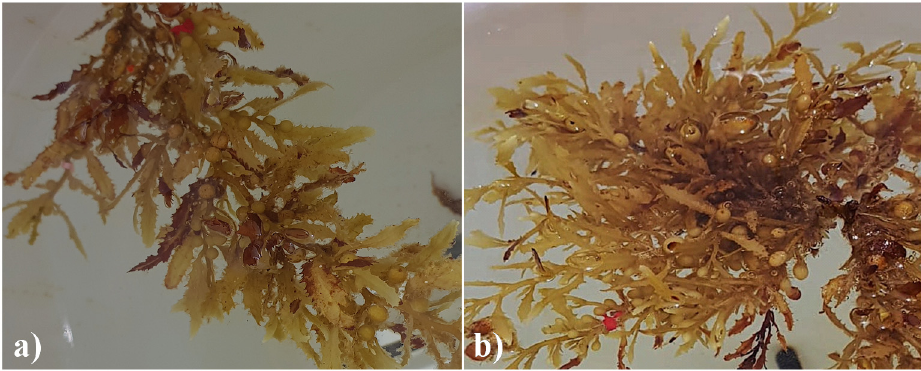
Figure 1. The Sargassum species used in this work, ( a ) S. fluitans and ( b ) S. natans .